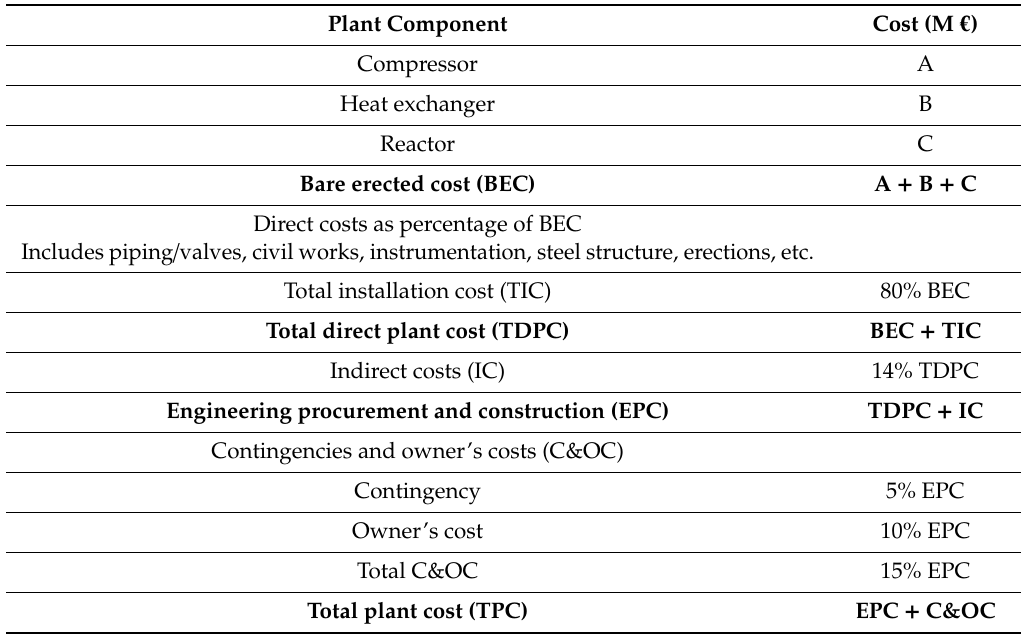
Table 8. Methodology for the TOC calculation [56].